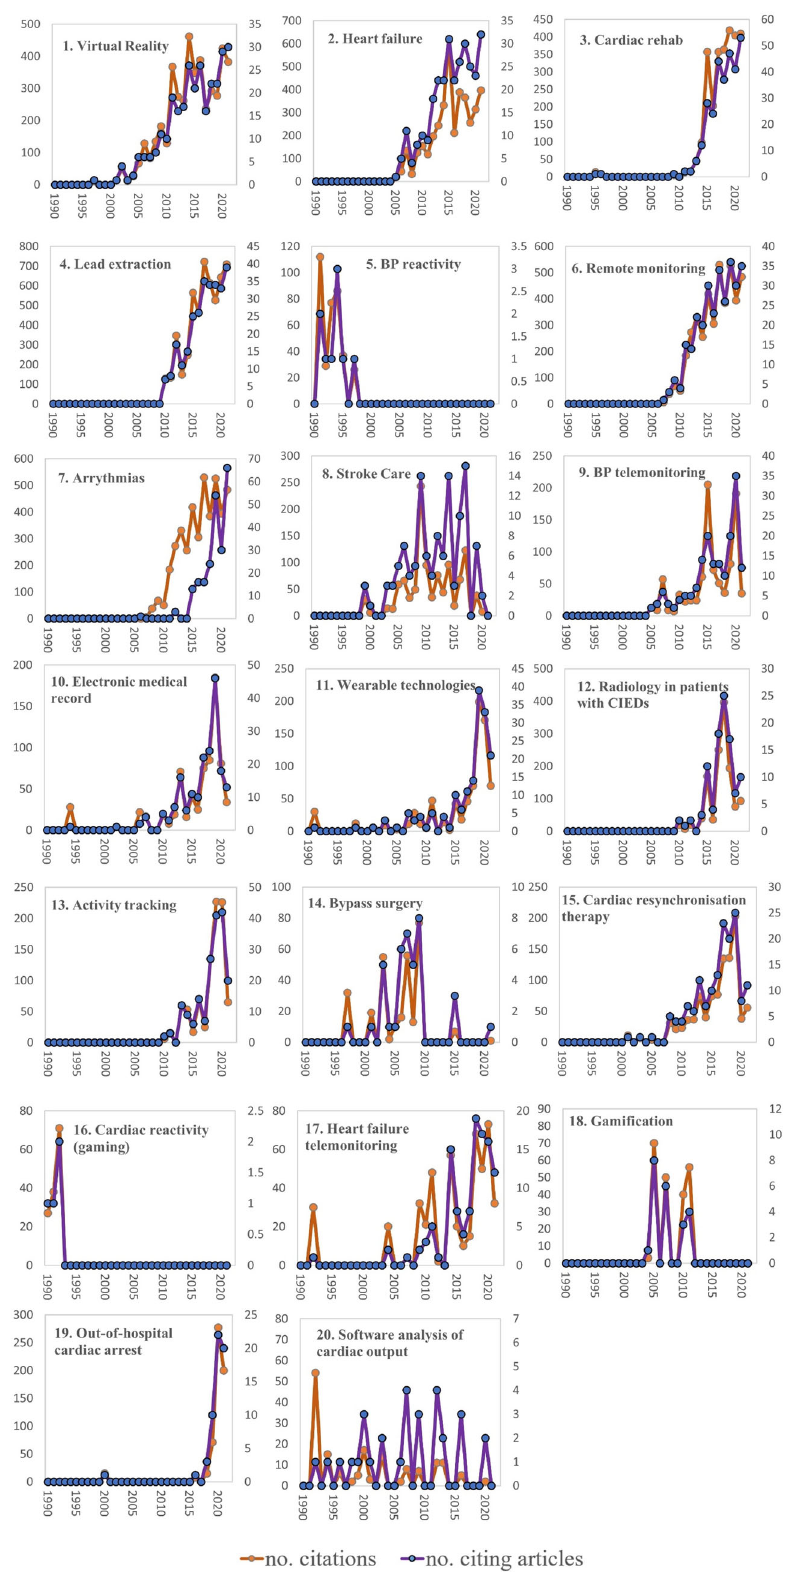
Fig. 6 Number of citations (orange datapoints) and number of citing articles (blue datapoints) for each cluster. Left axis: total number of citations; Right axis: total number of citing articles. Note: scale is different for each